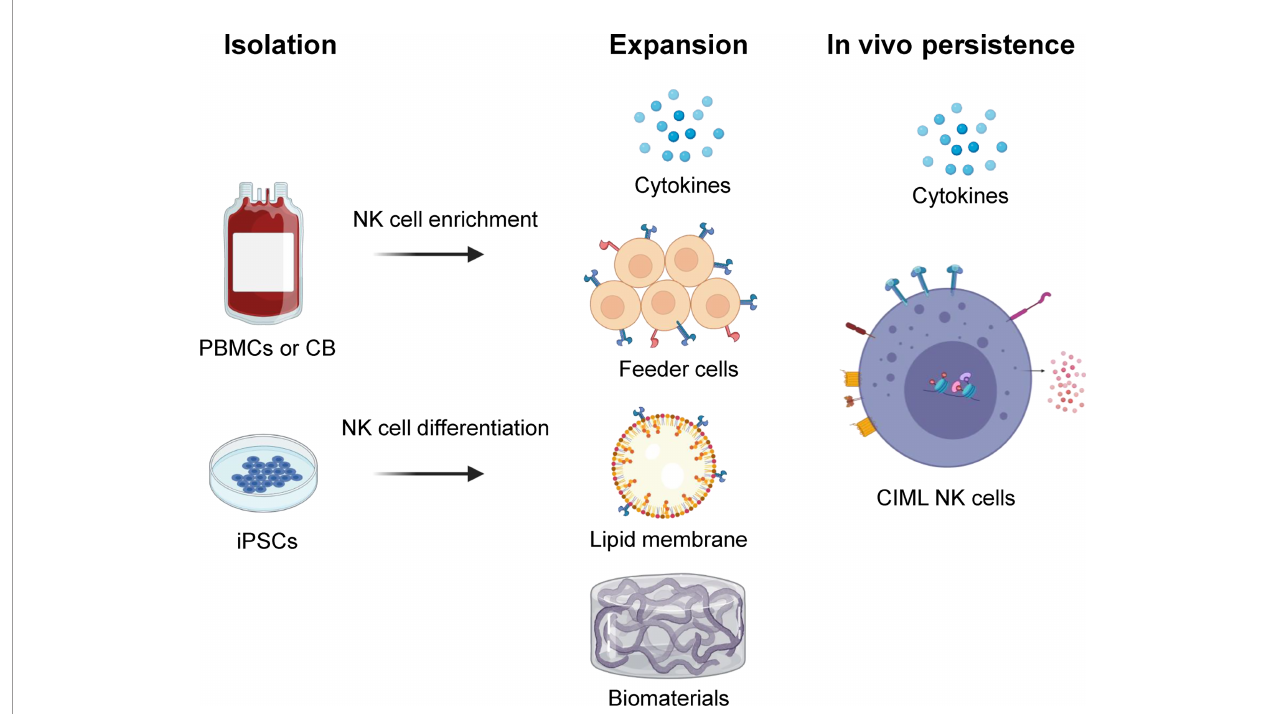
FIGURE 1 | Overview of NK cell isolation, expansion, and in vivo persistence. NK cells can be isolated and/or generated from peripheral blood (PB), cord blood (CB), or human induced pluripotent stem cell (iPSC) sources. They are expanded ex vivo using various strategies including cytokine combinations, feeder cells, lipid membranes or biomaterials that carry surface markers to provide biochemical cues. In vivo persistence of NK cells can be accomplished using cytokines like IL-15 and/or cytokine-induced memory-like (CIML) NK cells that have shown long term persistence in an immune compatible environment. Illustration created using